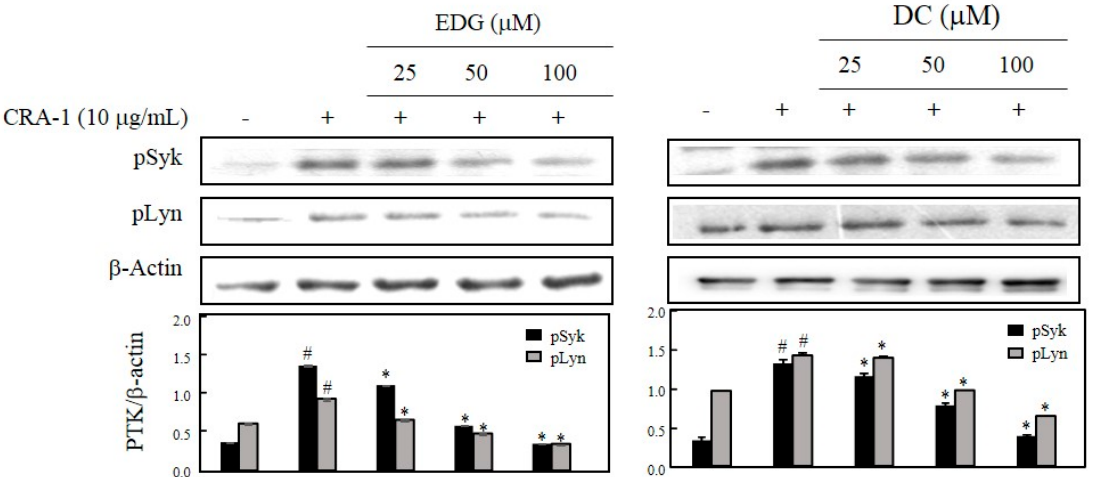
Figure 4. E ff ects of EDG and DC on Fc ε RI-mediated protein tyrosine kinases (PTKs) Syk and Lyn. Cells Figure 4. Effects of EDG and DC on Fc ε RI-mediated protein tyrosine kinases (PTKs) Syk treated with various concentrations of EDG and DC under serumfree conditions and stimulated with and Lyn. Cells treated with various concentrations of EDG and DC under serumfree CRA-1. Cellular lysates were obtained, and Syk, Lyn, and β -actin expression analyzed by Western blot conditions and stimulated with CRA-1. Cellular lysates were obtained, and Syk, Lyn, and analysis using corresponding antibodies. Relative density calculated as ratio of each protein expression β -actin expression analyzed by Western blot analysis using corresponding antibodies. to β -actin. # p < 0.05 vs. non-treated group; * p < 0.05 vs. CRA-1-treated